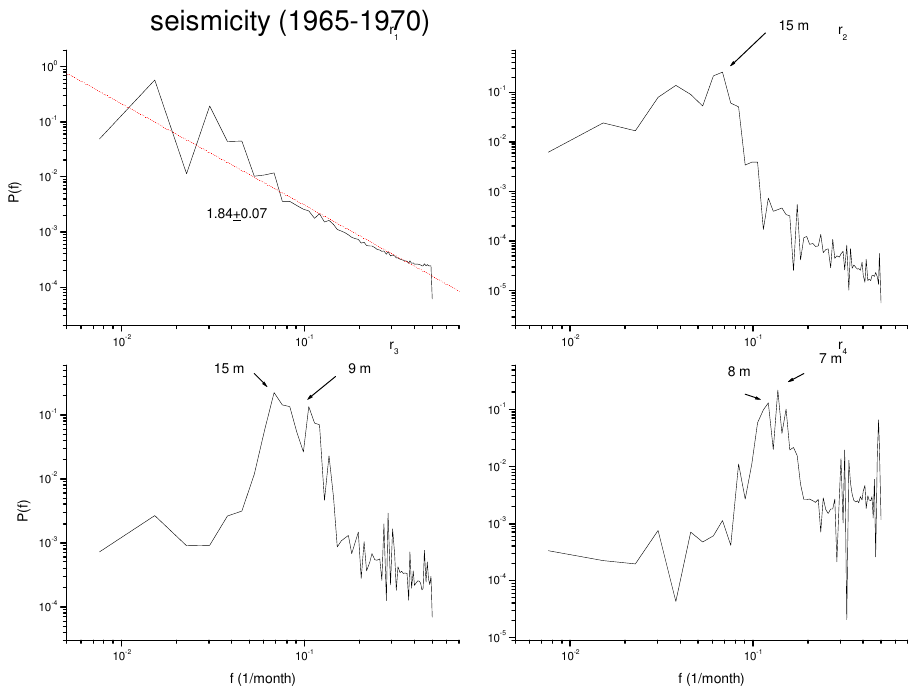
Fig. 8. Power spectrum of the first reconstructed components of the monthly number of earthquakes that occurred in the investigated area from 1965 to 1970.